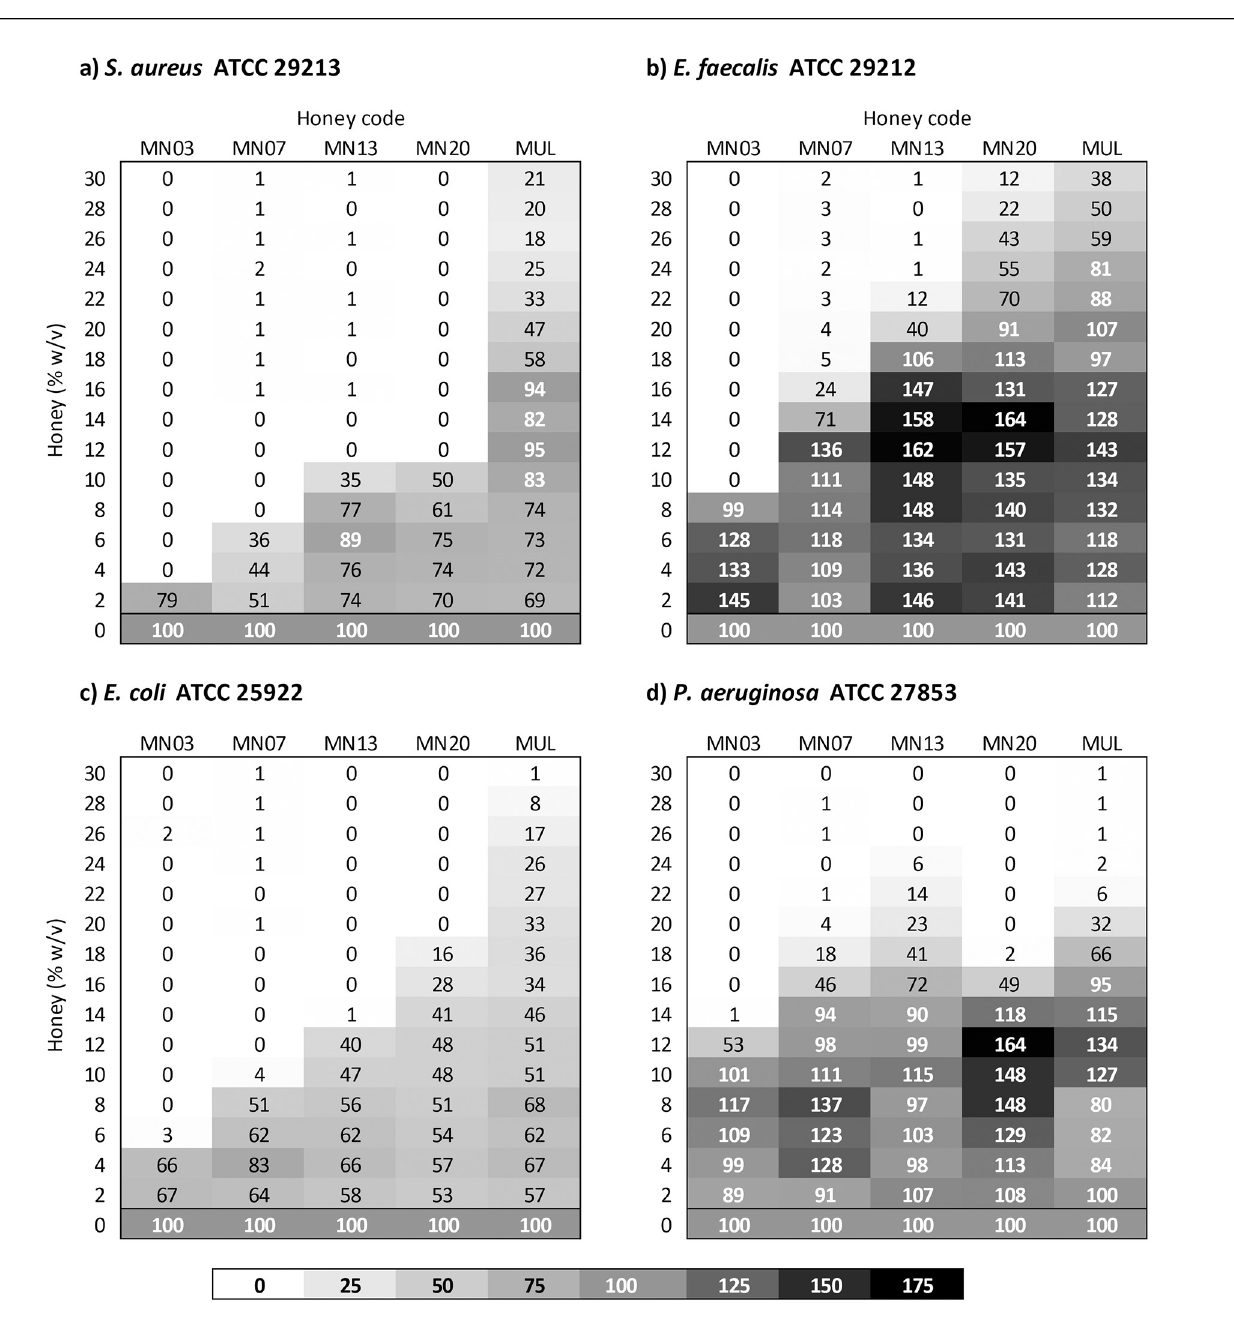
PLOS ONE | https://doi.org/10.1371/journal.pone.0272376 July 28,